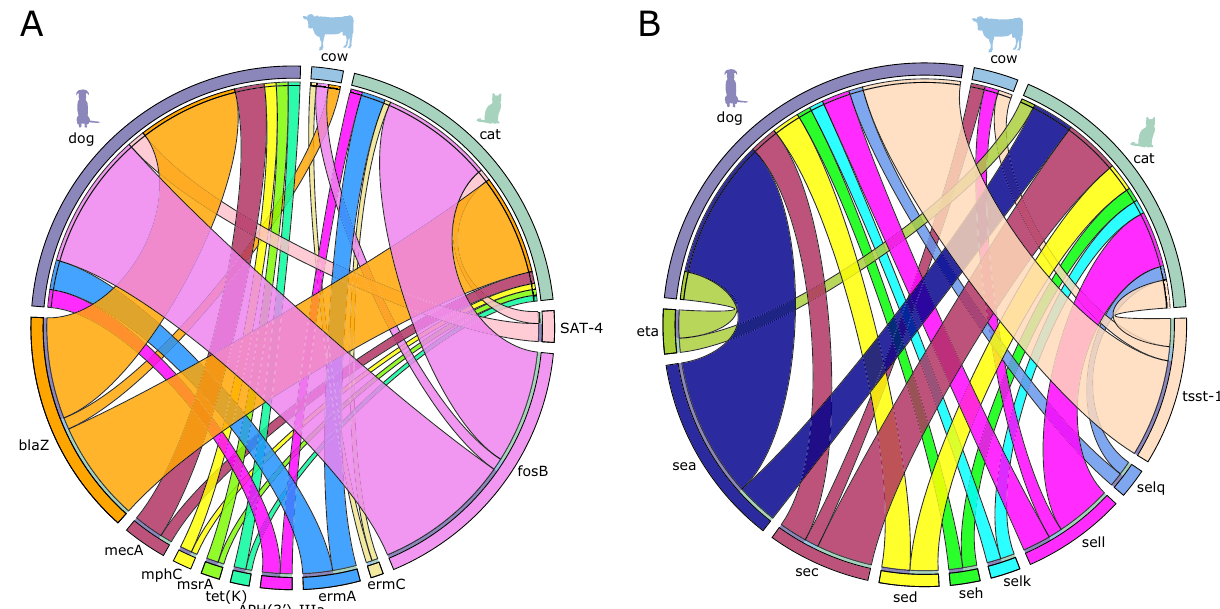
Figure 4. Distribution of antibiotic resistance ( A ) and superantigen ( B ) genes in S. aureus from cats, cows, and dogs. Only genes present in more than one isolate are shown and only the three most common animals were included. The outer ring of the upper half of circos plots represent the number of isolates sampled from dogs (purple), cows (light blue), and cats (light green). The outer ring of the bottom half of the circos plots represent the number of isolates that carry the shared antibiotic resistance genes (panel A) and superantigen genes (panel B). Connecting lines between the specific gene and the animal host are shown if the gene was detected in isolates from any of the three animal